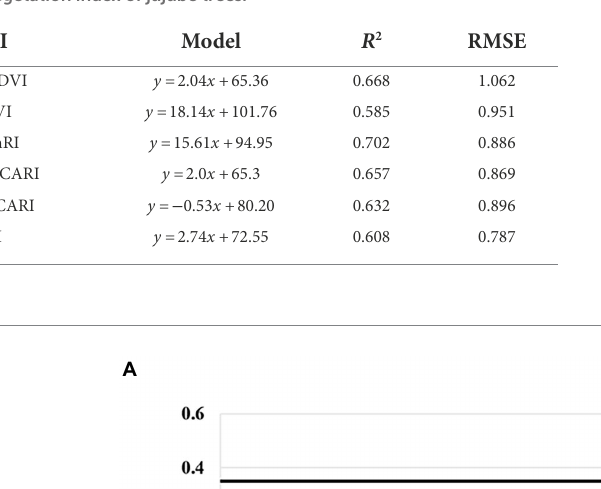
TABLE 3 Correlation between SPAD values of canopy leaves and vegetation index of jujube trees.